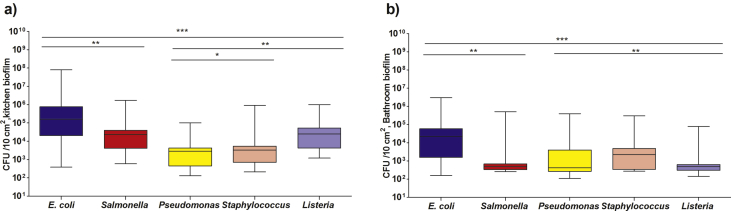
Average counts of some bacterial pathogens in household biofilm samples, ∗ indicated to low correlation (P ≤ 0.05), ∗∗ indicated to moderate correlation (P ≤ 0.01), ∗∗∗ indicated to high correlation (P ≤ 0.001).